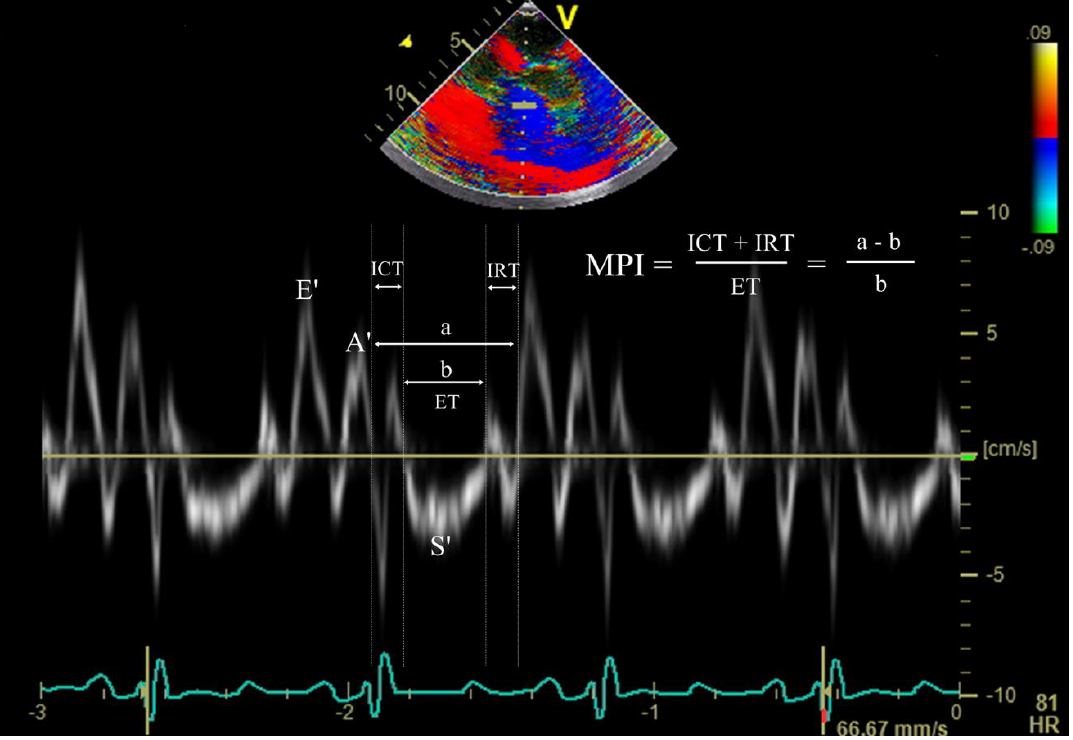
Figure 1. Doppler tissue waves derived from the septal mitral annulus, and time intervals required for calculation of myocardial performance index. E’, peak early diastolic mitral annular velocity; A’, late diastolic mitral annular velocity; S’, peak systolic mitral annulus velocity; ICT, isovolumic contraction time; IRT, isovolumic relaxation time; ET, ejection time; MPI, myocardial performance index.